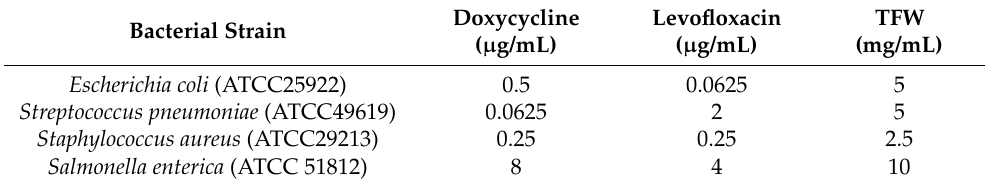
Table 7. The results of the antibacterial activities of TFW